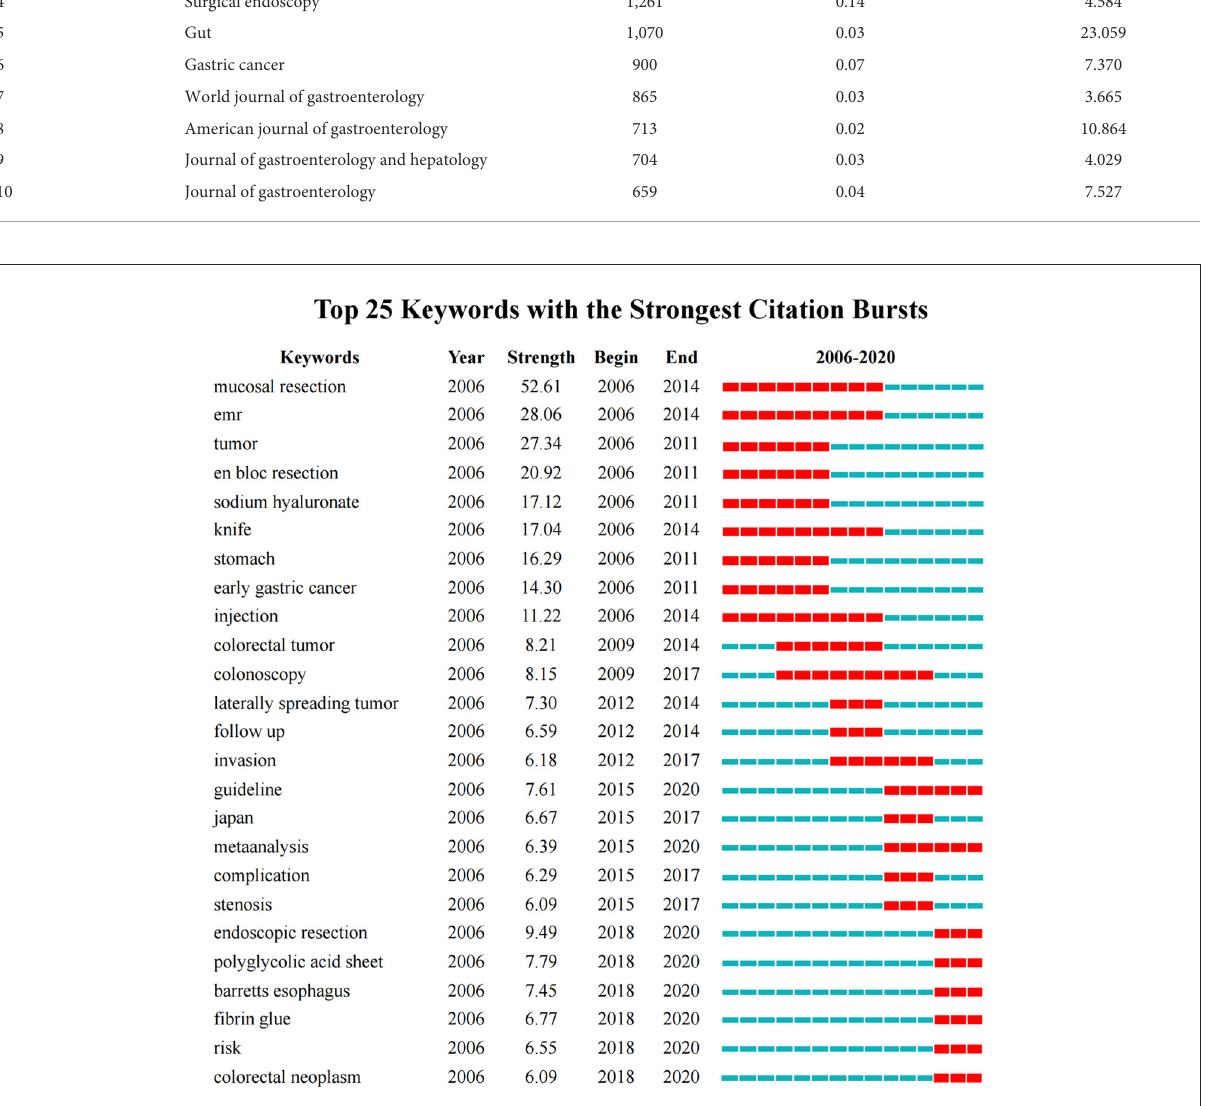
FIGURE6 Keywords with the strongest citation bursts in published articles on ESD, 2006-2020. The timeline is depicted as a blue line, and the time interval that a subject was found to have a burst is shown as a red segment which indicated the beginning year, the ending year, and the duration of the